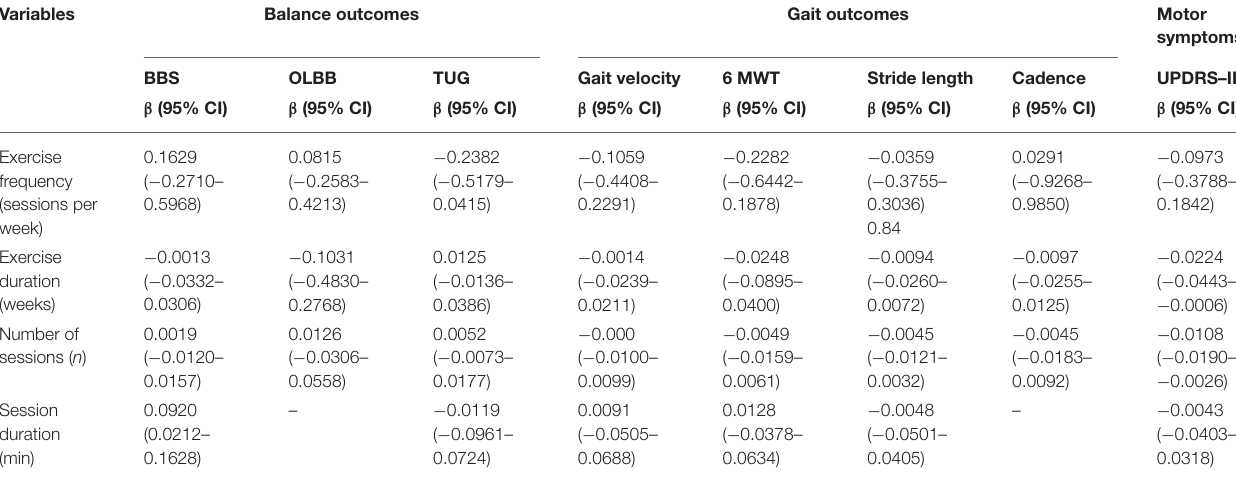
TABLE 5 | Meta-regression of the 15 included studies to predict TCE effects on measurement outcomes.